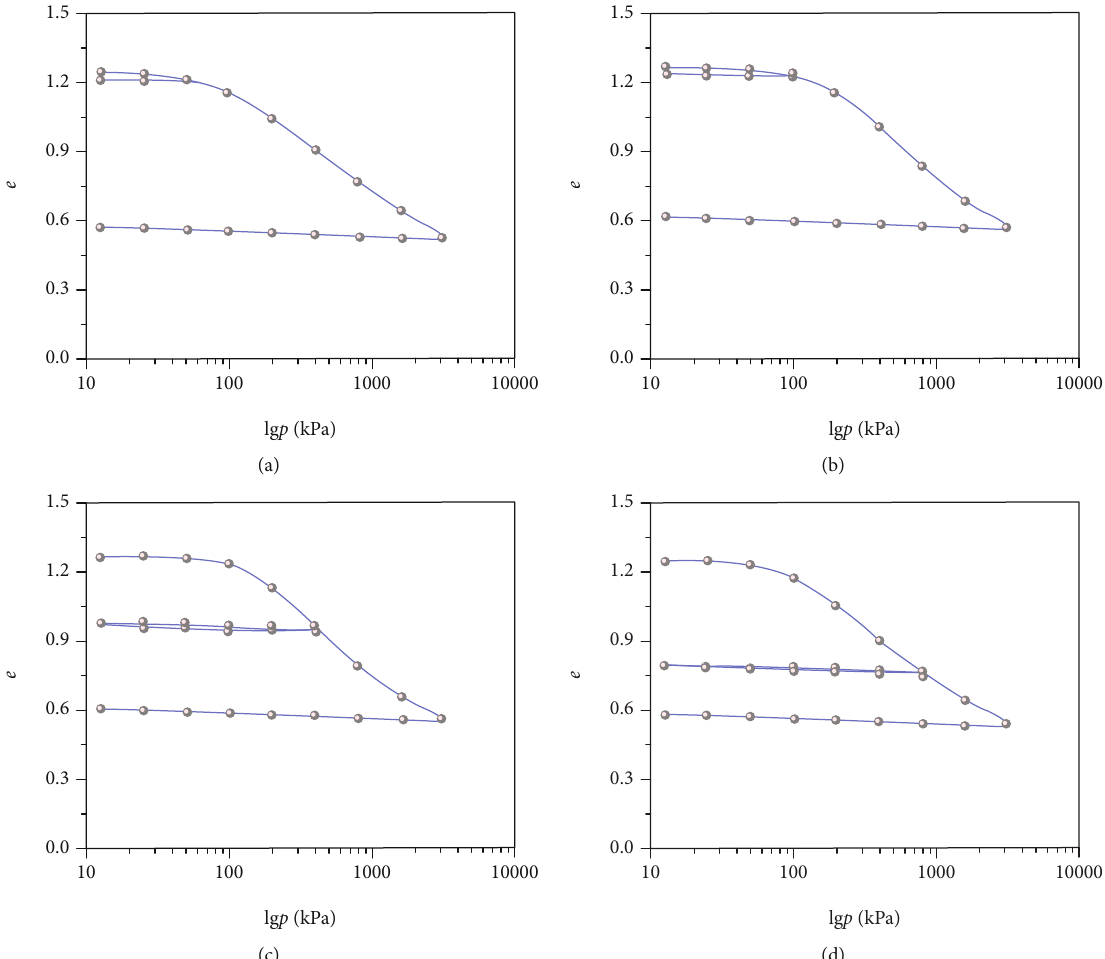
Figure 4: Loading-unloading compression lines for undisturbed loess with the fi rst unloading excursion originating at (a) p = 50kPa , (b) p = 100kPa , (c) p = 400 kPa , and (d) p = 800kPa